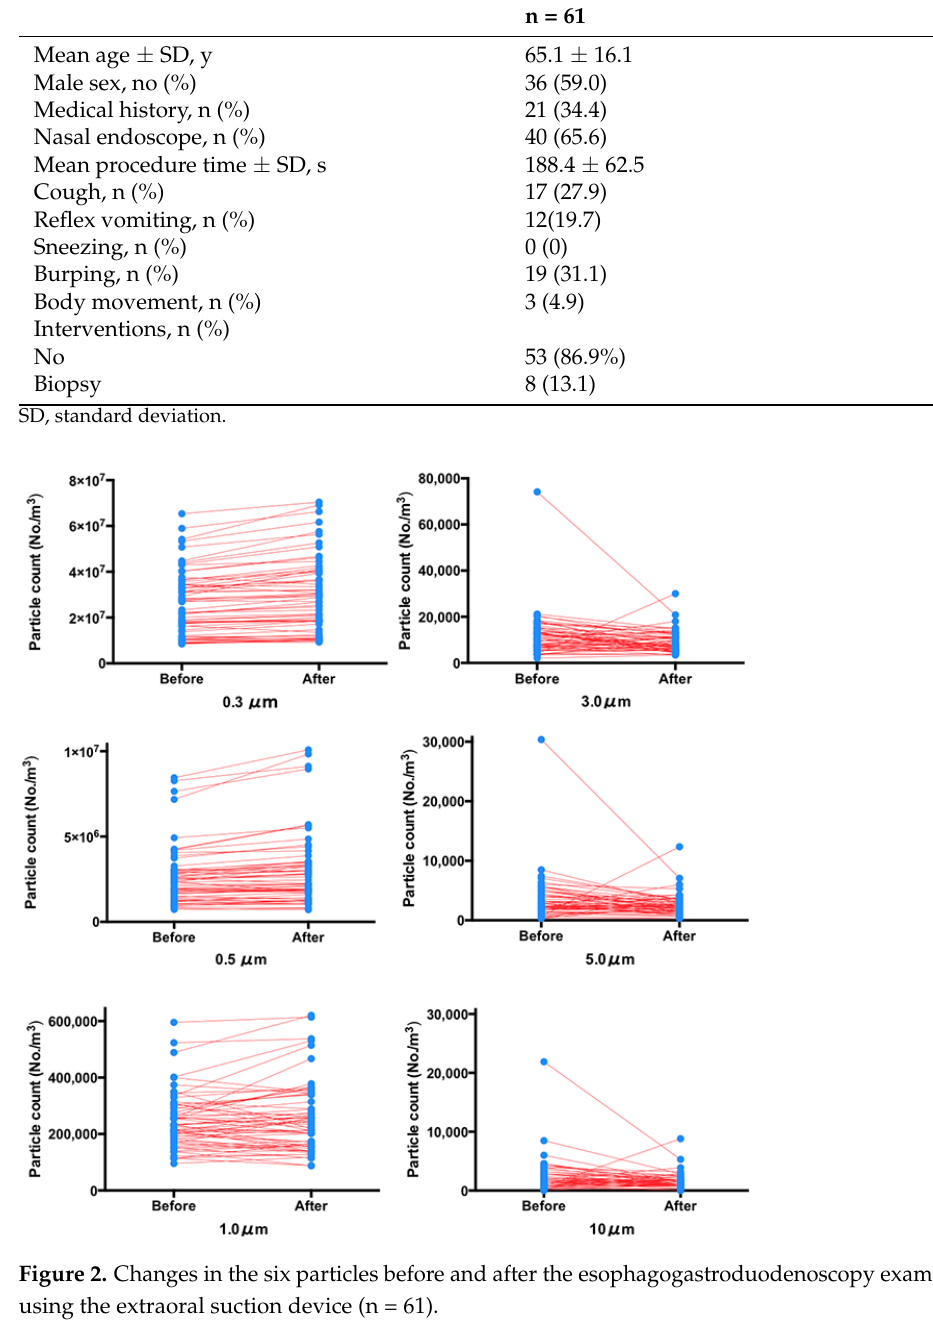
Figure 3. Percentage increase in aerosol particles of 0.3, 0.5, 1, 3, 5, and 10 μm in size at 60, 120, 180 and 240 s from the start of esophagogastroduodenoscopy (n = 54). The lines represent the mean particle count (0.3, 0.5, 1, 3, 5, and 10 μm) of the 54 patients using the extraoral suction device. The blue dotted line indicates the 95% confidence interval.